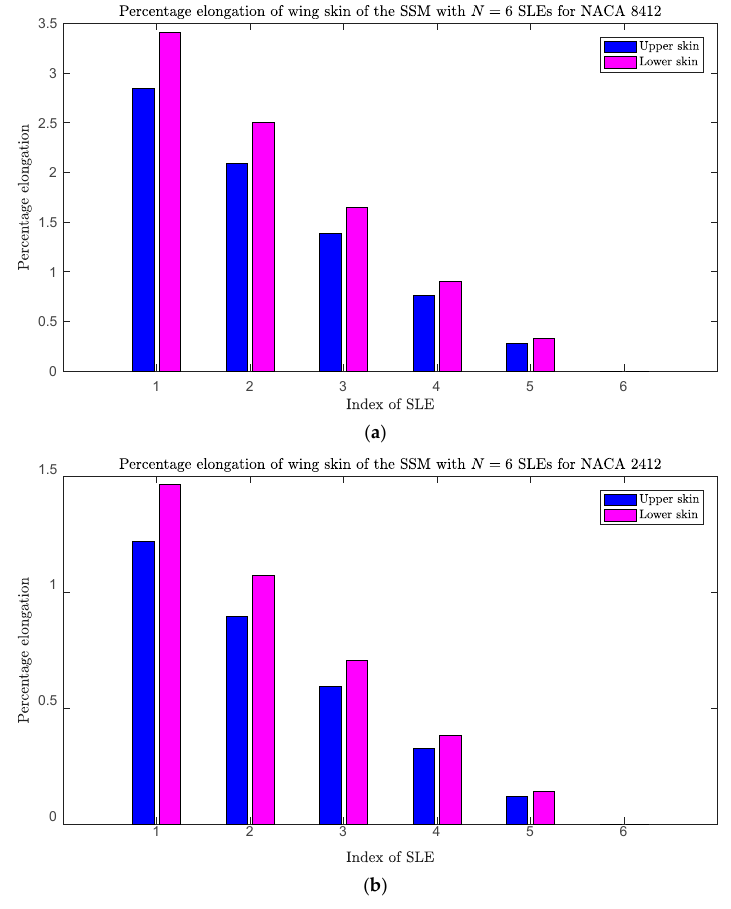
Figure 8. Percentage elongation of wing skin segments of the SSM with N = 6 SLEs for: ( a ) NACA 8412; ( b ) NACA 2412.